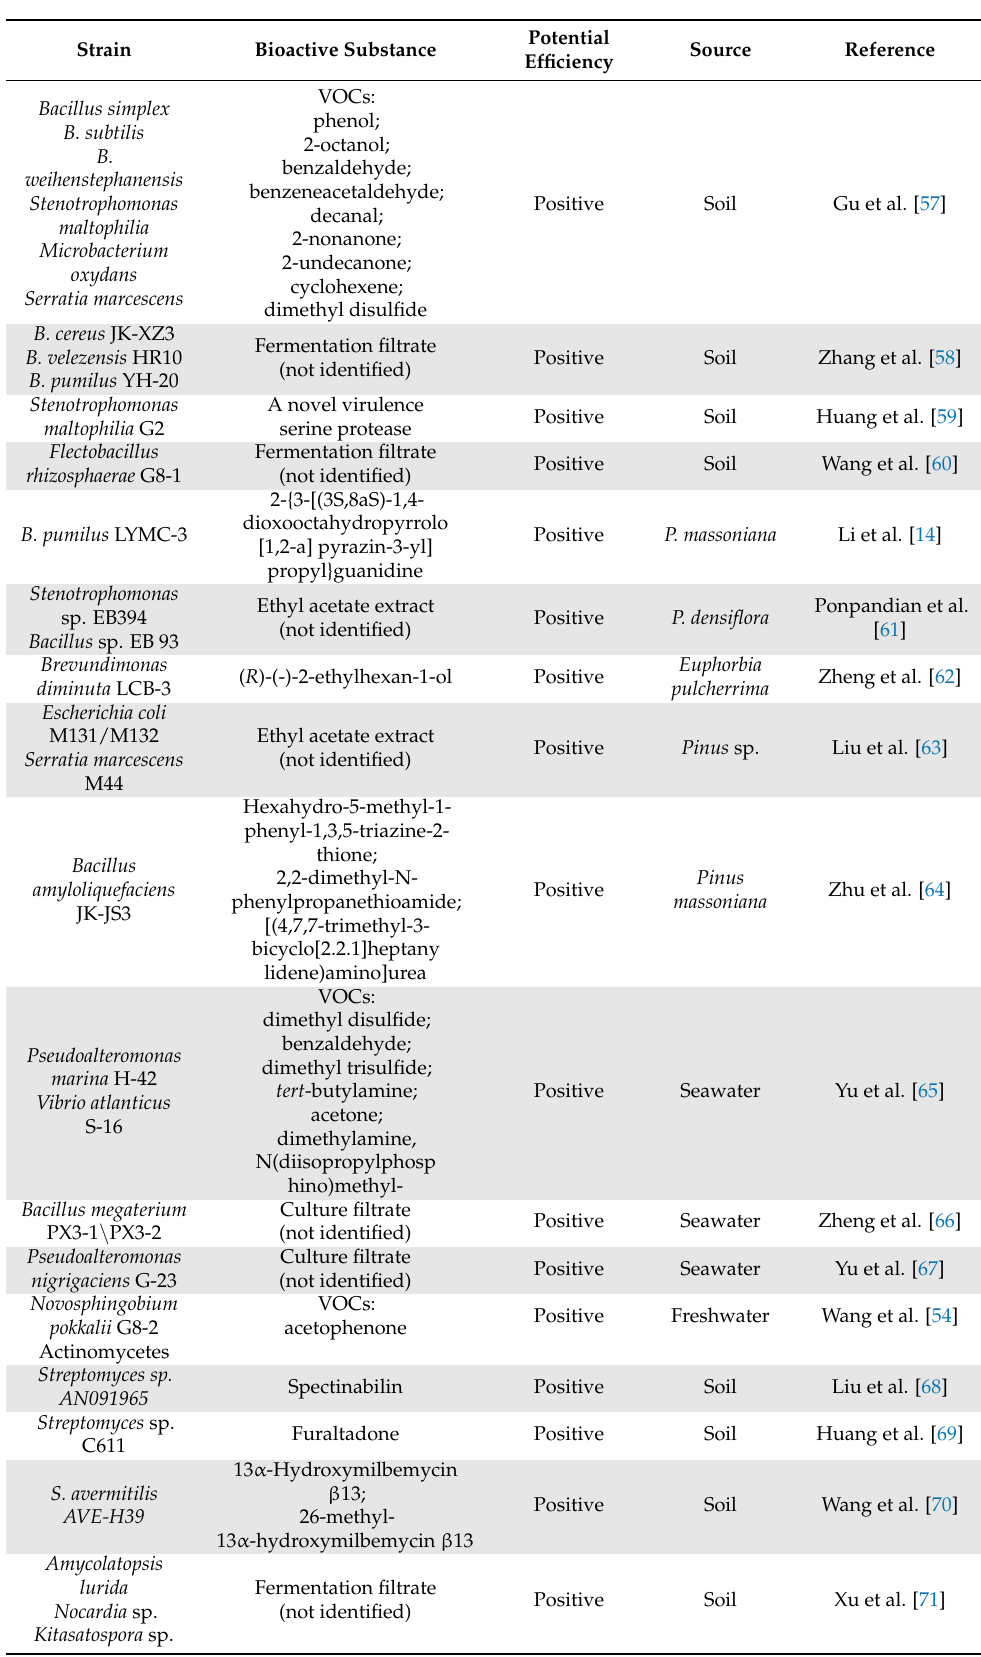
Table 1. Cont. Strain Bioactive